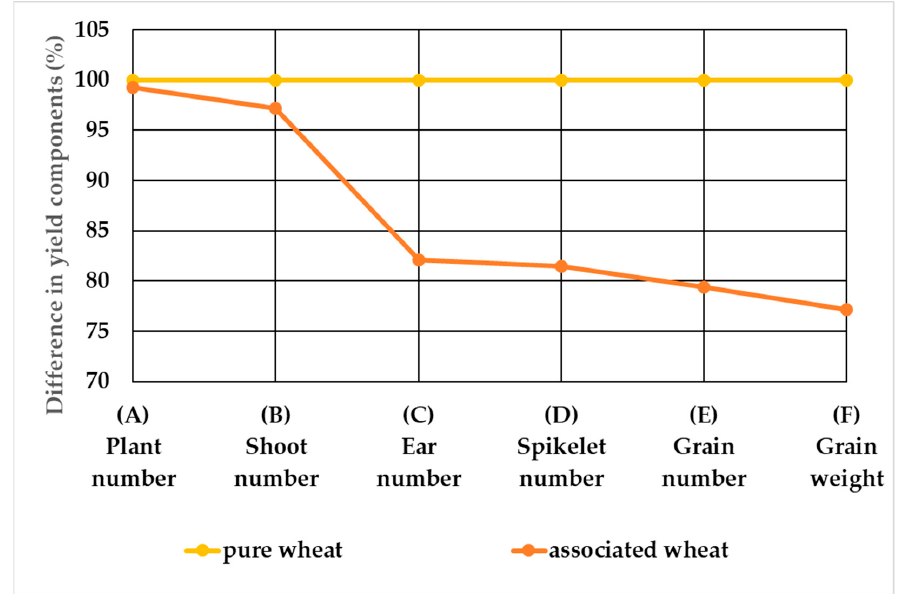
Figure 2. Development line of pure wheat ( Triticum aestivum L.) and associated wheat over an average of 2 years.